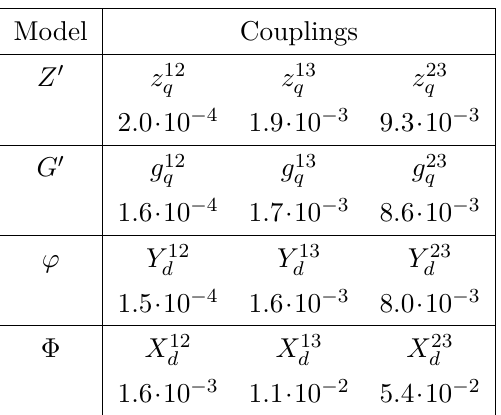
(cid:2) (cid:3) M ij 12 BSM